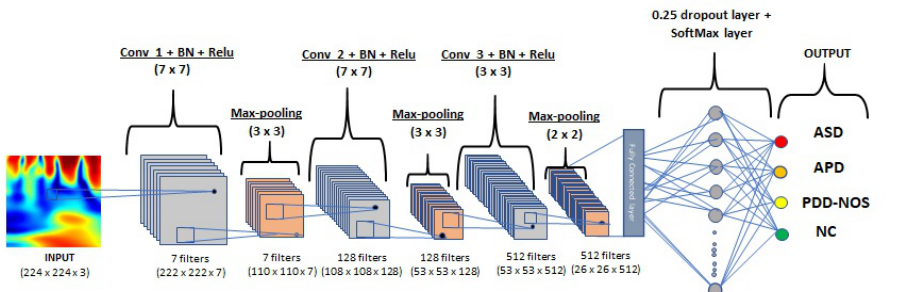
Figure 3. Training parameters: Batch size = 32, Epochs = 20, Learning rate = 0.0005. 3-layer CNN architecture for wavelet coherence scalogram classification into three ASD subtypes and normal